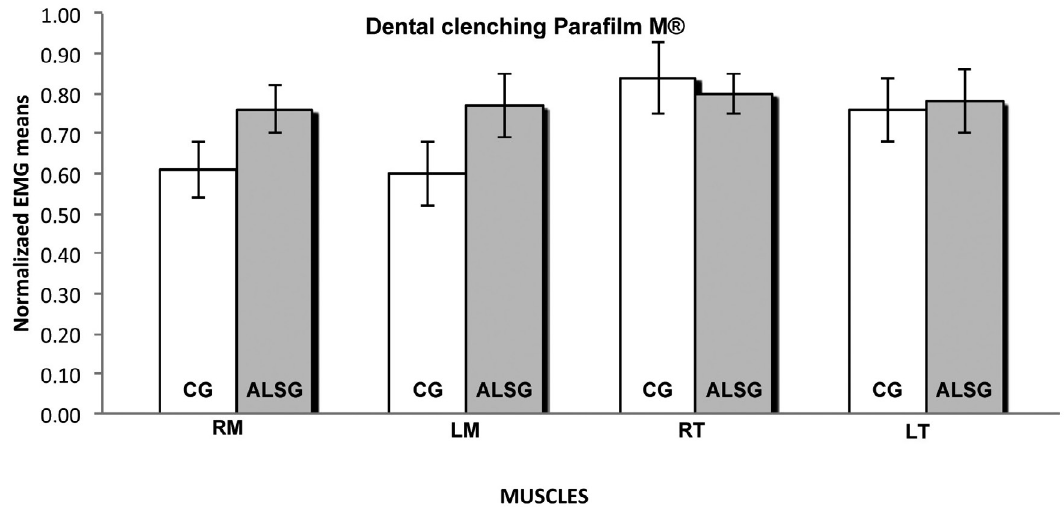
Figure 5- Normalized electromyography data of masseter (RM: right masseter; LM: left masseter) and temporalis (RT: right temporal; LT: left temporal) muscles for CG and ALSG in the dental clenching Parafilm M ®